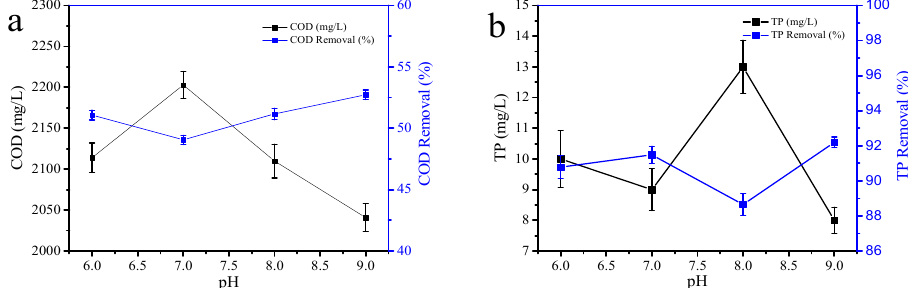
Figure 5. Effect of pH on CEPT efficiencies: ( a ) COD removal and ( b ) TP removal (FeCl 3 40 mg/L, APAM 0.2 mg/L).